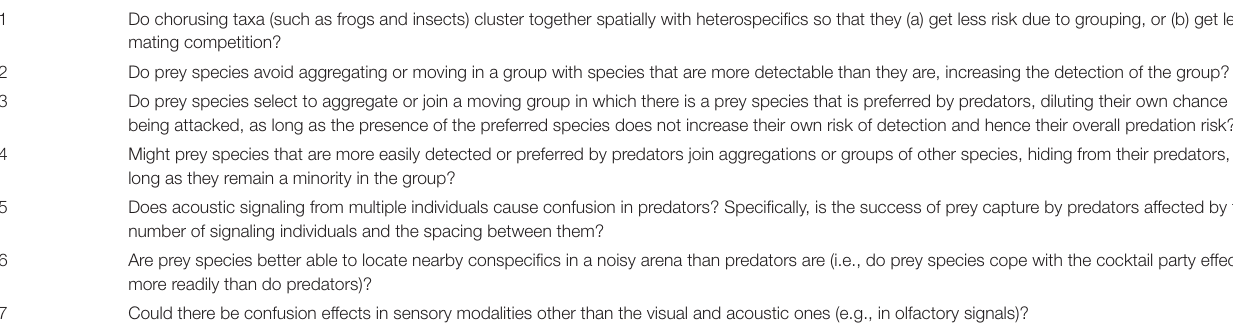
TABLE 1 | Fruitful directions for future research on how the social environment of prey species influences predator